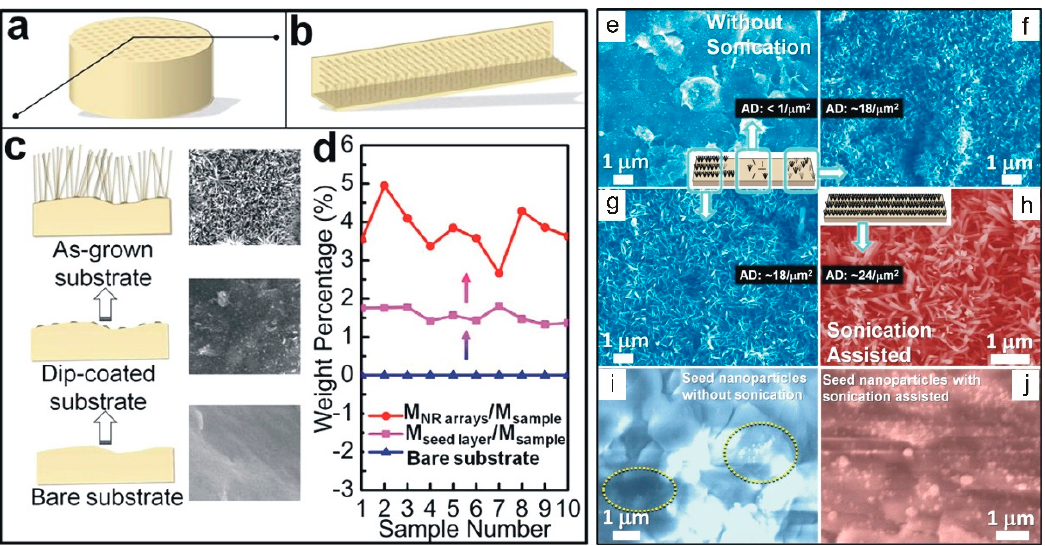
Figure 2. ( a , b ) Schematic illustrations of ( a ) monolithic cordierite substrate and ( b ) as-grown nanorod (NR) arrays inside each channel; ( c ) Cross-sectional diagram of the ZnO NR array growth process; ( d ) Weight percentages of seed layer and as-grown ZnO NR arrays with respect to the total masses of dip-coated and as-grown substrates, respectively. SEM images of synthesized ZnO NR arrays: ( e – g ) different channel regions of an as-grown sample whose seed nanoparticles were dip-coated without ultrasonic vibration; ( h ) ZnO NR arrays grown in the center channel surface region of an as-grown sample whose seed nanoparticles were dip-coated with ultrasonic vibration; and ( f – i ) seed nanoparticles dip-coated with and without ultrasonic vibration assistance. Reprinted with permission from [14], Copyright ACS, 2013.